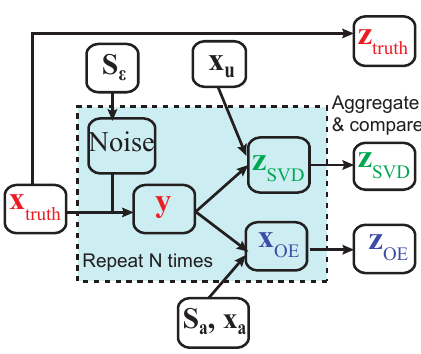
Figure 5. Comparing SVD and OE retrievals: using simulated data y generated from a CO 2 profile x truth , we perform SVD and tra- ditional OE retrievals and compare their results averaged over an N = 1000 ensemble projected onto the z basis. Specifically, we look at the variance and the bias compared to z truth , which is projected from x truth . We specify an uninformative prior x u for the SVD re- sults and a Bayesian prior mean x a and prior covariance matrix S a